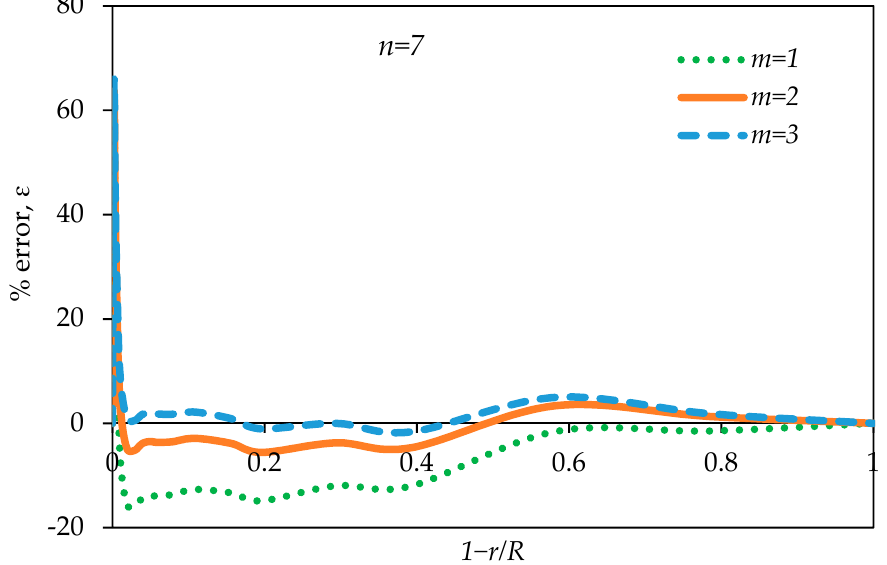
Figure 12. Percentage errors between the measured and calculated profiles for the old and new power laws.